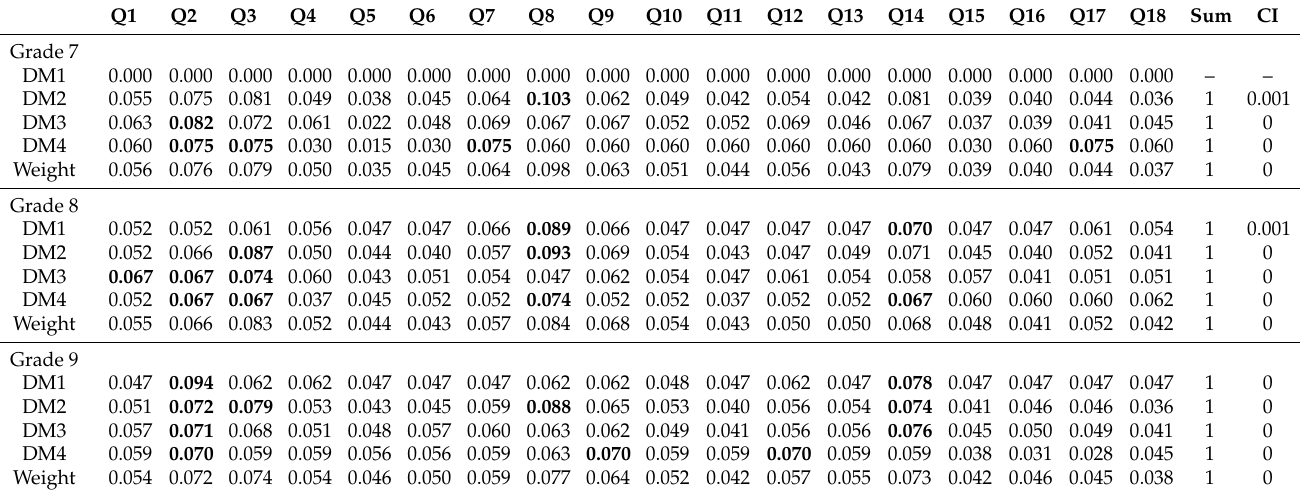
Table 4. The weight and ranking of VGAS criteria for middle school students (grades 7, 8, and